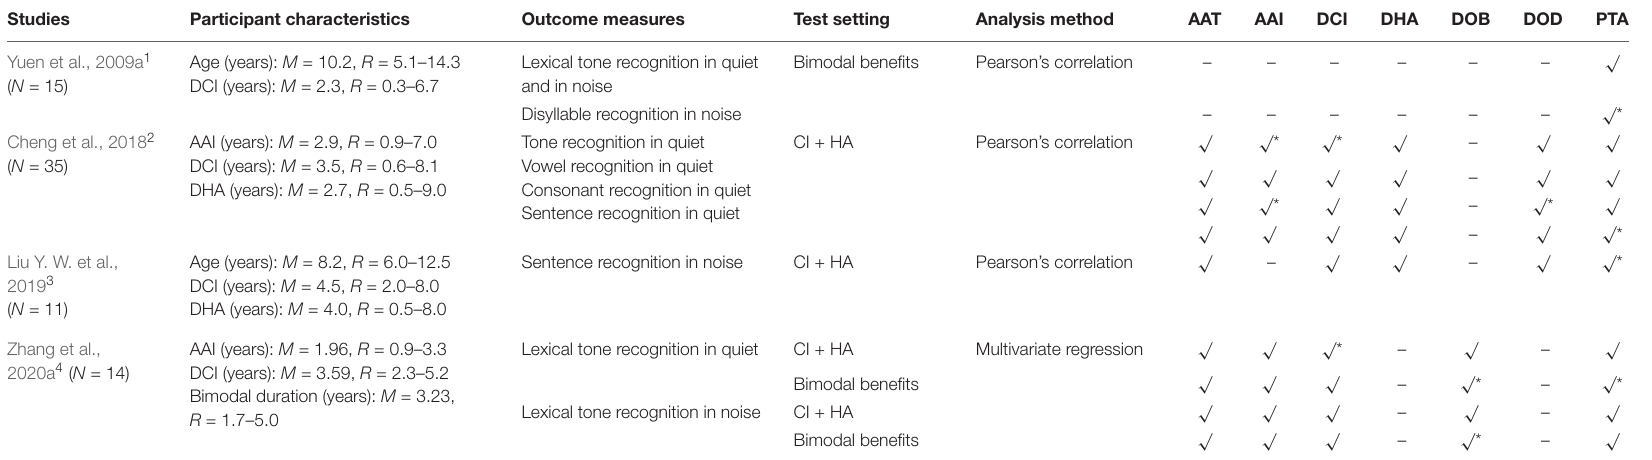
TABLE 6 | Factors that affect speech perception of children with bimodal stimulation.